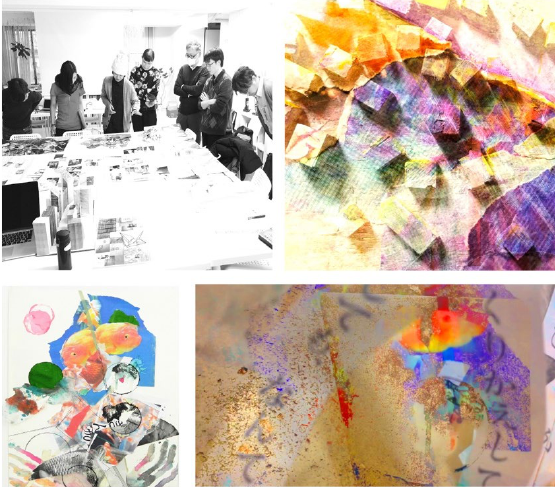
Figure 24 Workshop series “Alchemy of Architecture” and participants' work.